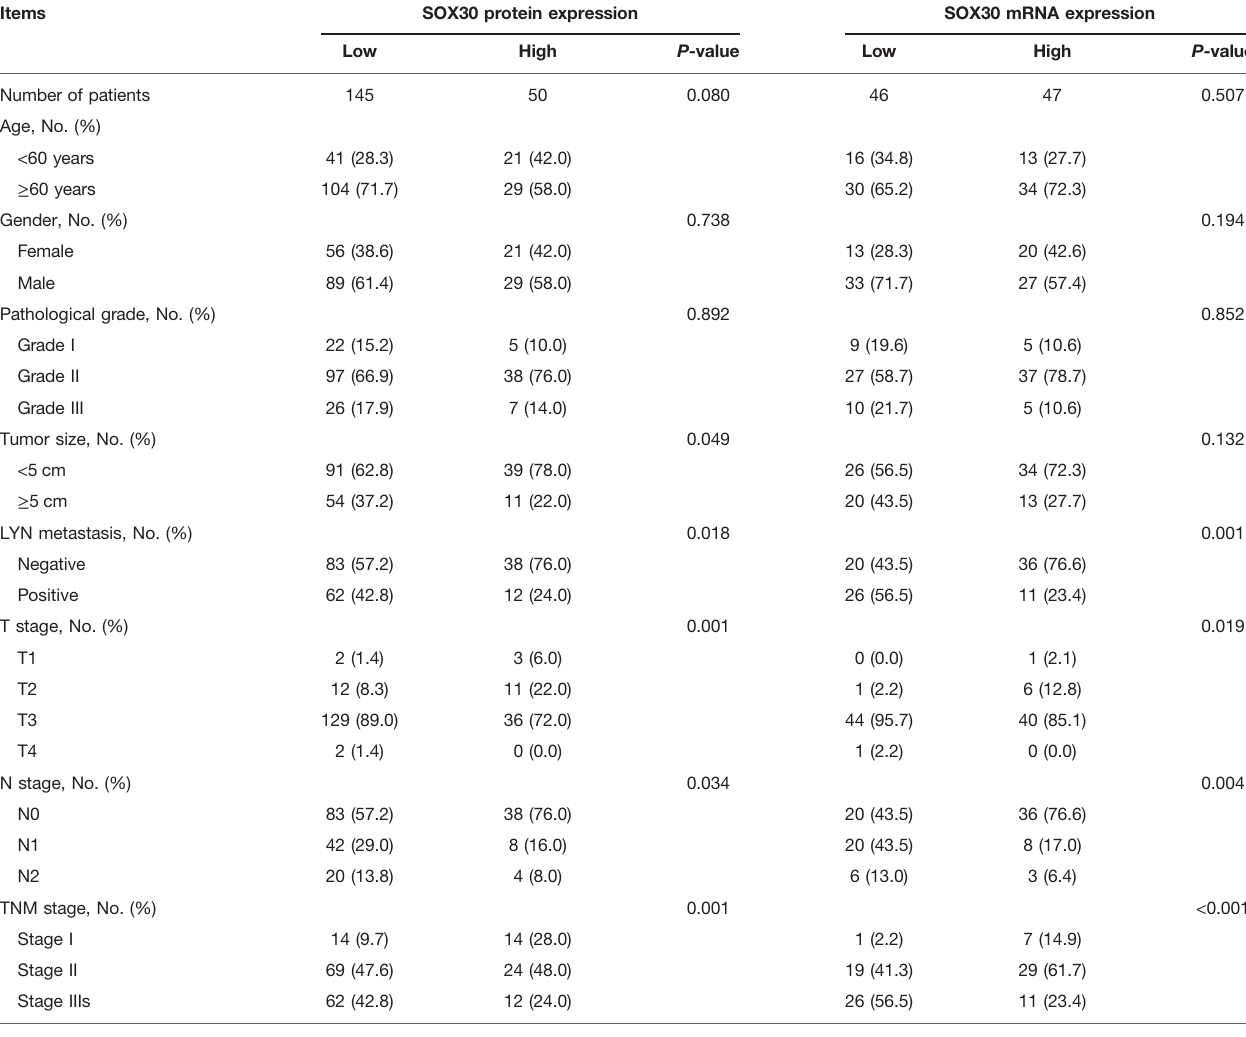
TABLE 2 | Correlation of tumor SOX30 with clinicopathological features.